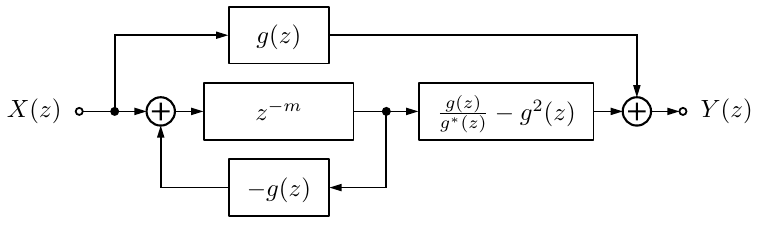
Figure 2. Gerzon’s allpass filter with feedforward/-back gain g ( z )